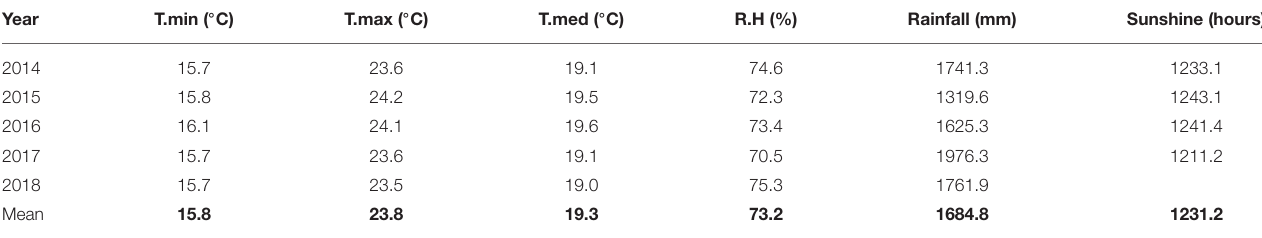
TABLE 1 | Climatic conditions obtained from the weather station.